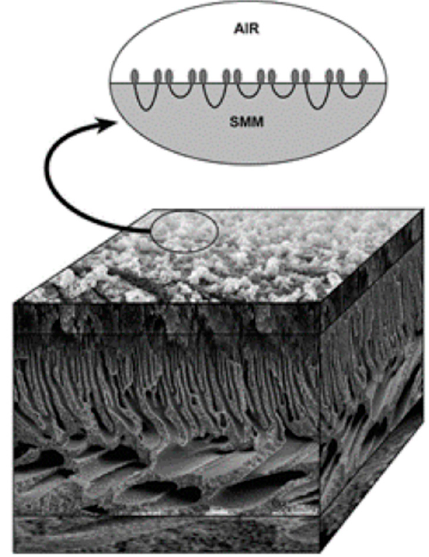
Figure 7. Ultrastructure of filter membrane’s skin layer after its surface functionalization with chemical groups (adapted from [172], with permission).